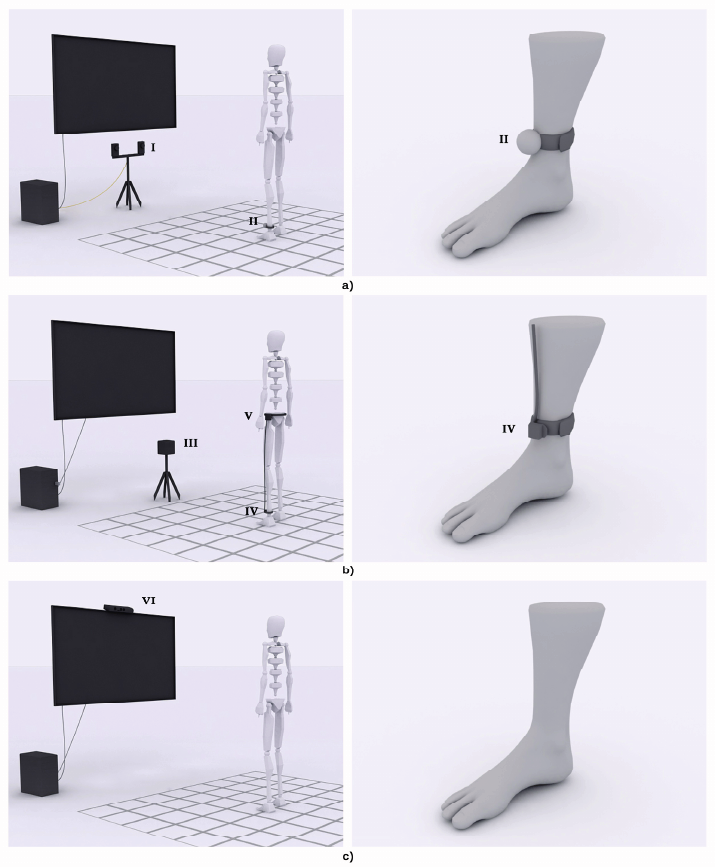
Figure 1. Setting of the tracking systems. Three different tracking systems were tested in the study. ( a ) The optical tracking solution used two cameras (I) and a passive reflective marker (II); ( b ) The electromagnetic tracking solution used a source (III) and a sensor (IV), wire connected to a hub (V); ( c ) The skeleton tracking solution used a depth sensor